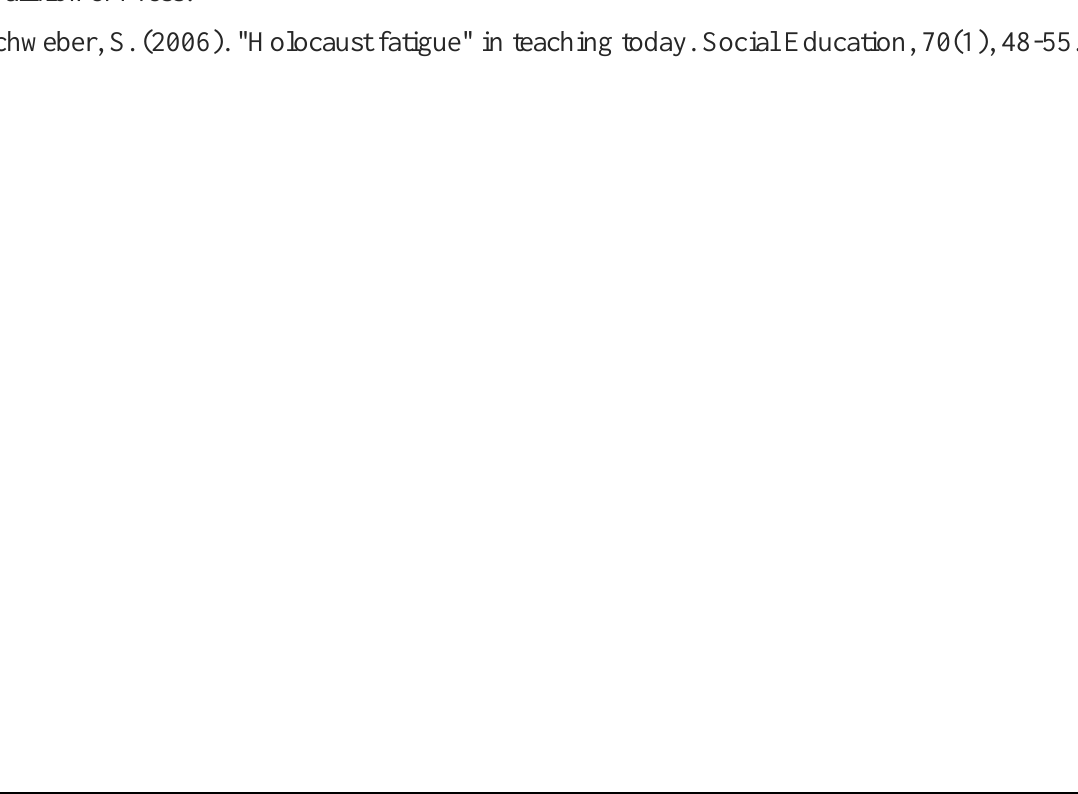
CINEJ Cinema Journal: Holocaust Cinema as Depicted by Film Advisory Boards in Five English Speaking